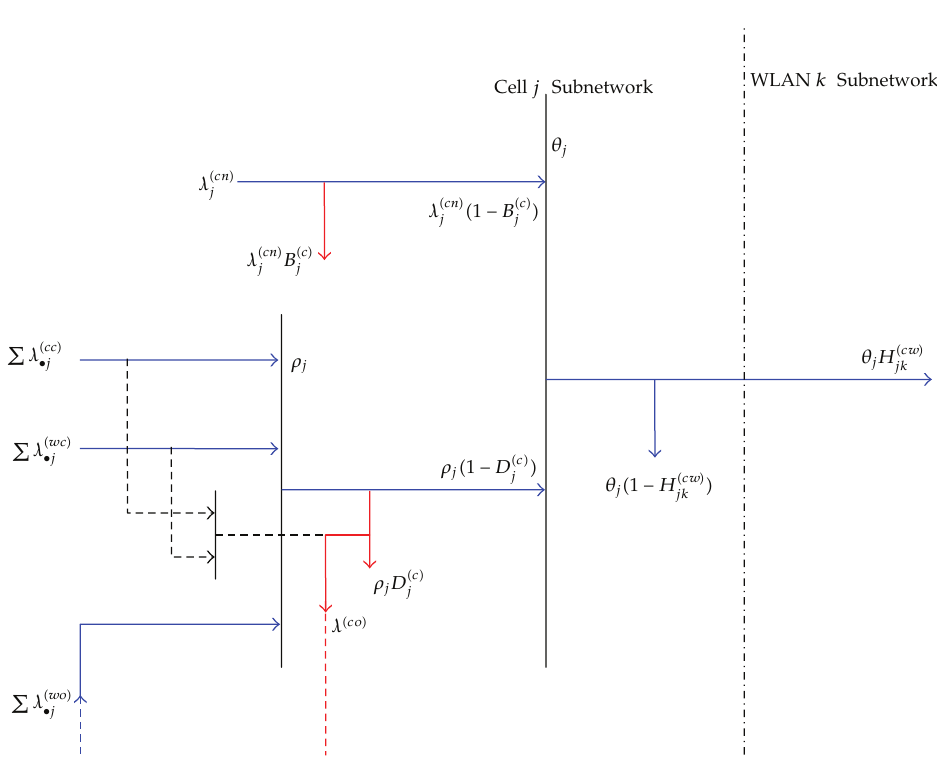
Figure 6: Vertical handover tra ffi c from cellular cell to